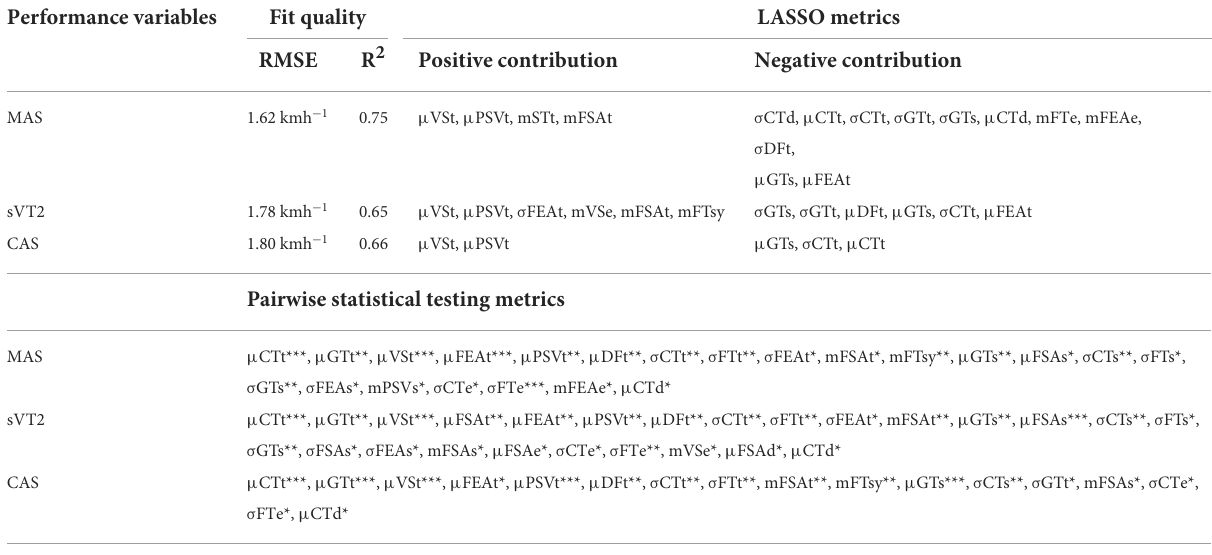
TABLE 3 Biomechanical metrics selected through LASSO regression and statistical testing.